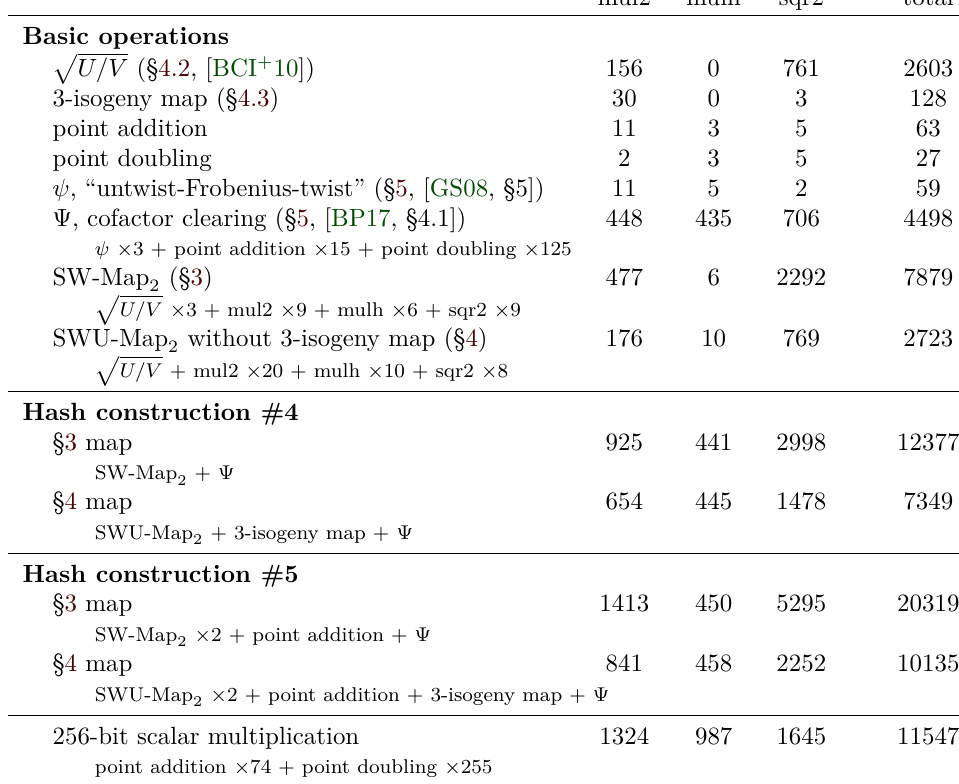
Table 3: Costs for constant-time hash constructions #4 and #5 to G 2 (Table 1). mul2